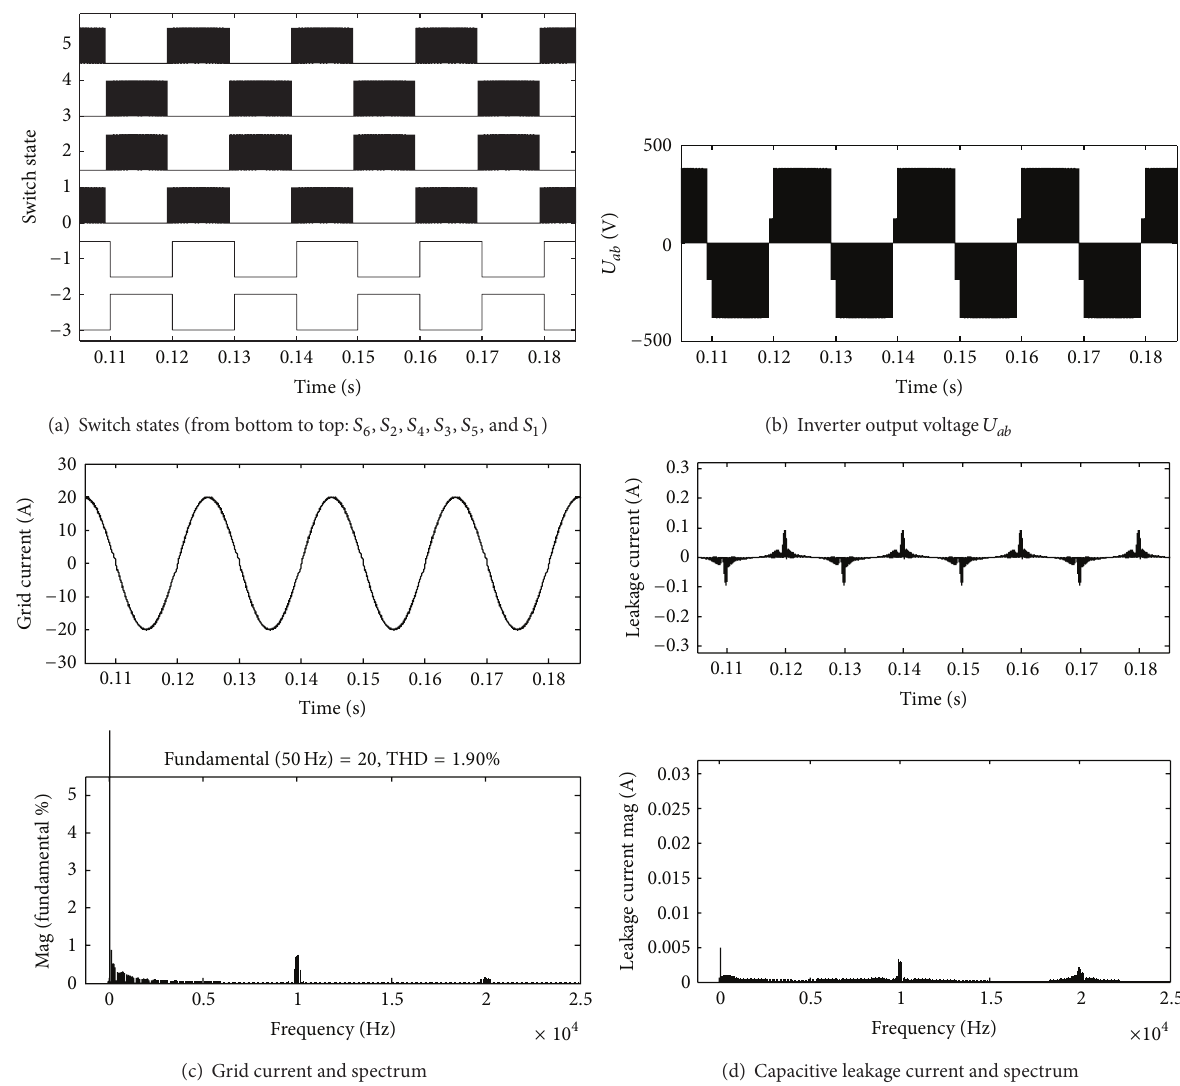
(d) Capacitive leakage current and spectrum Figure 5: Test